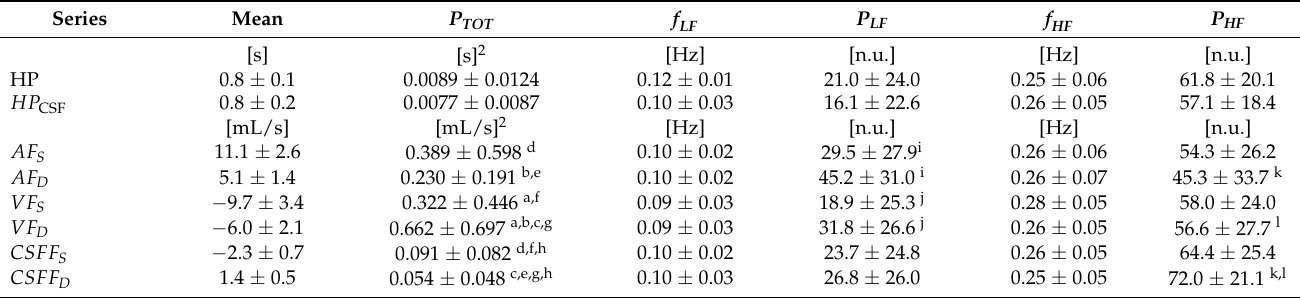
Table 1. Results of AR PSD decomposition. Values are reported as average ± std in the group of 30 healthy subjects. Significant post-hoc contrasts ( p < 0.05, two-way repeated measure-ANOVA) are noted with couples of letters (a–k). The p -value, effect size estimate Cohen’s dz and the observed power ( ω ) of each significant post-hoc comparison are reported in the